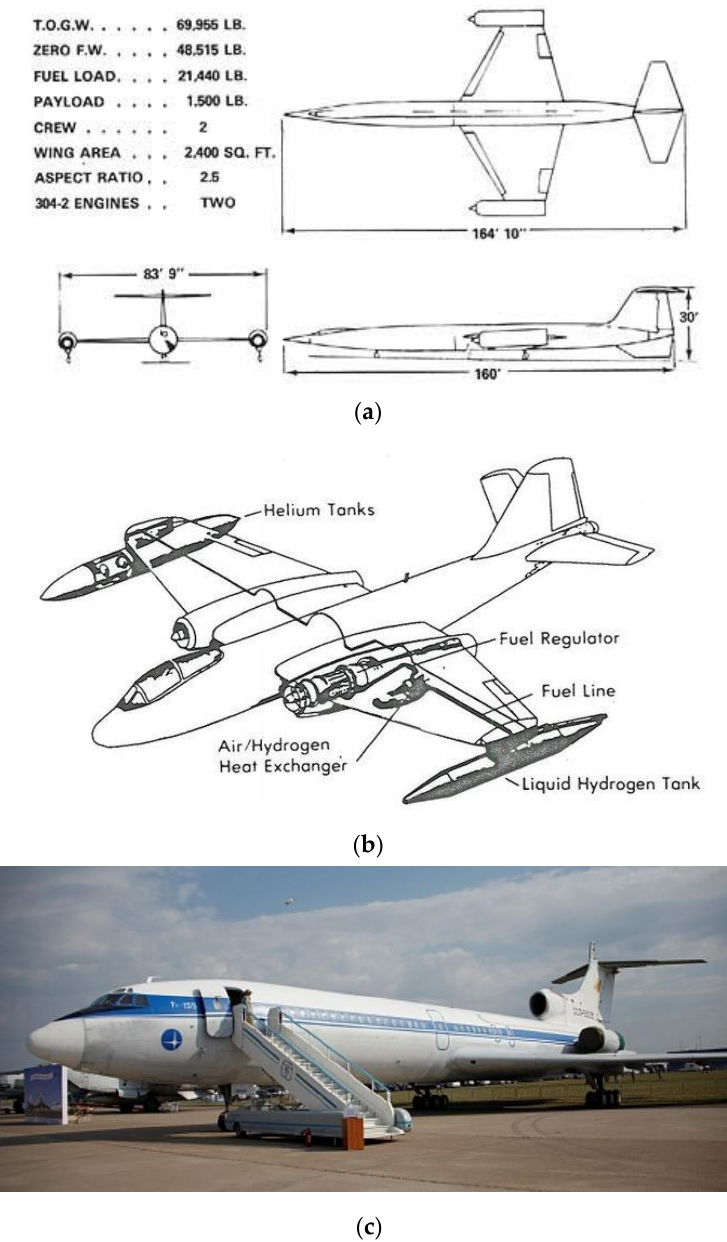
Figure 16. Examples of hydrogen-powered aircraft. ( a ) The Lockheed-Martin Suntan, taken from the symposium on hydrogen-fueled aircraft, NASA Langley Research Center, 15–16 May 1973 ( b ) B-57B aircraft with one engine capable of running on hydrogen, image is taken from NACA RM E57D23 ( c ) Tu-155 aircraft with one engine capable of running on hydrogen, image is taken from Tupolev history - http://www.tupolev.ru/en/about/#history_en.